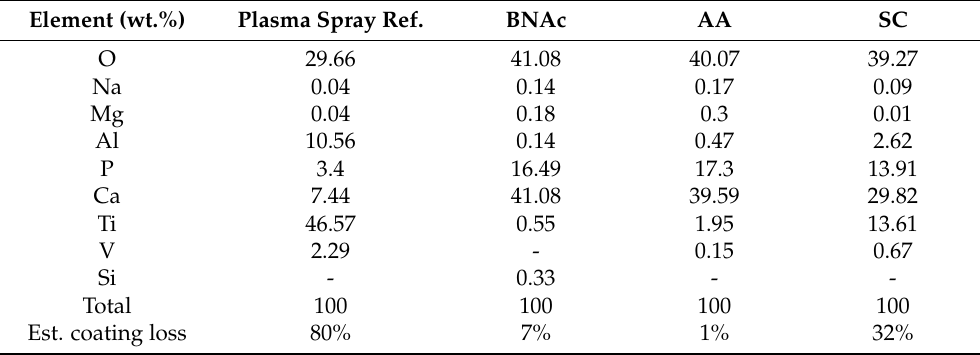
Table 4. EDX chemical analysis on adhesion tested parts in the centre of the breaking zone and estimation of coating